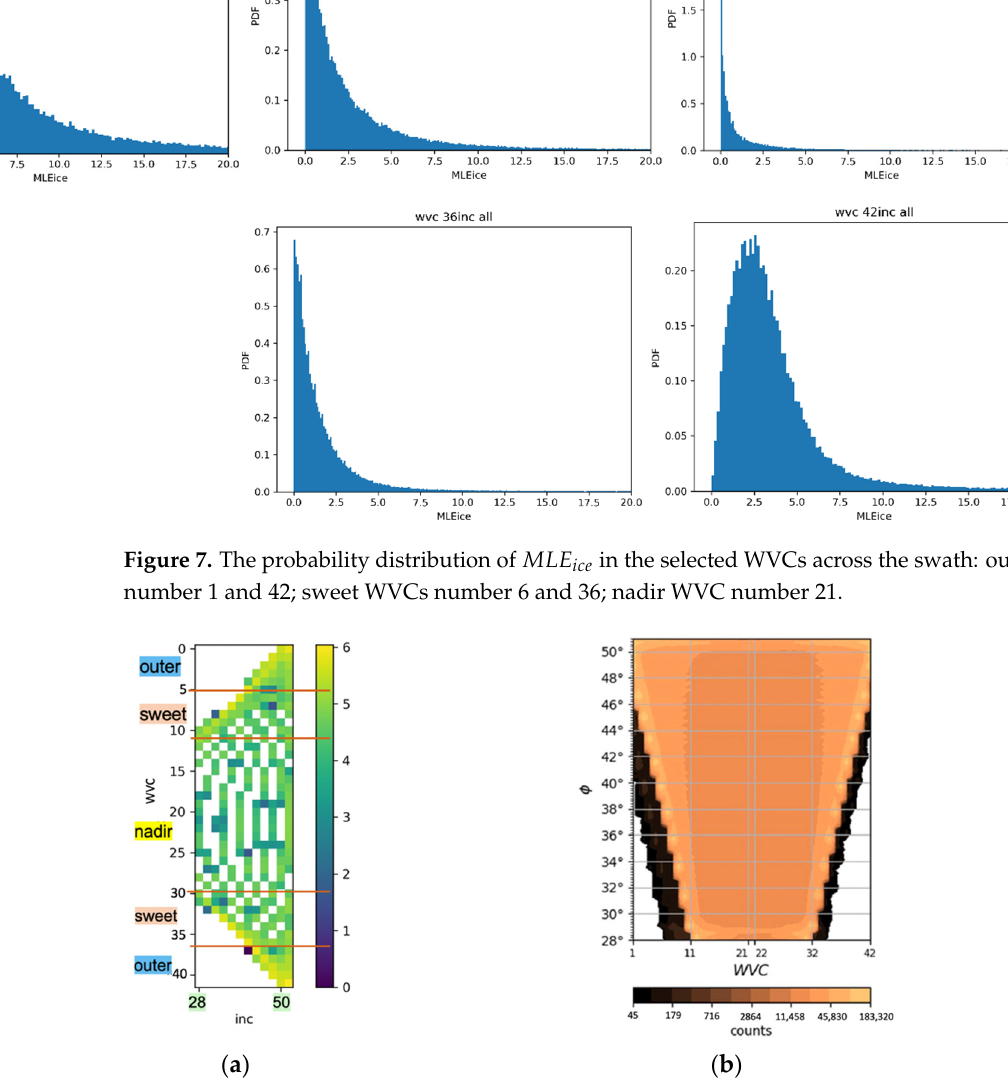
Figure 8. ( a ) the number of incidence angle HH/VV pairs across the swath (the number is logarithmic to make the plot clearer); ( b ) the distribution of the incidence angle across the swath.